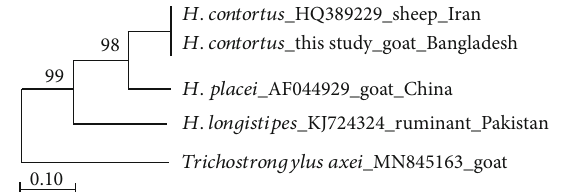
Figure 4: Phylogenetic relationships of present specimen ( H. contortus ) with other members of Haemonchidae reconstructed by the ML method based on the ITS sequences and numbers at the branch nodes indicate percentage bootstrap support for 1000